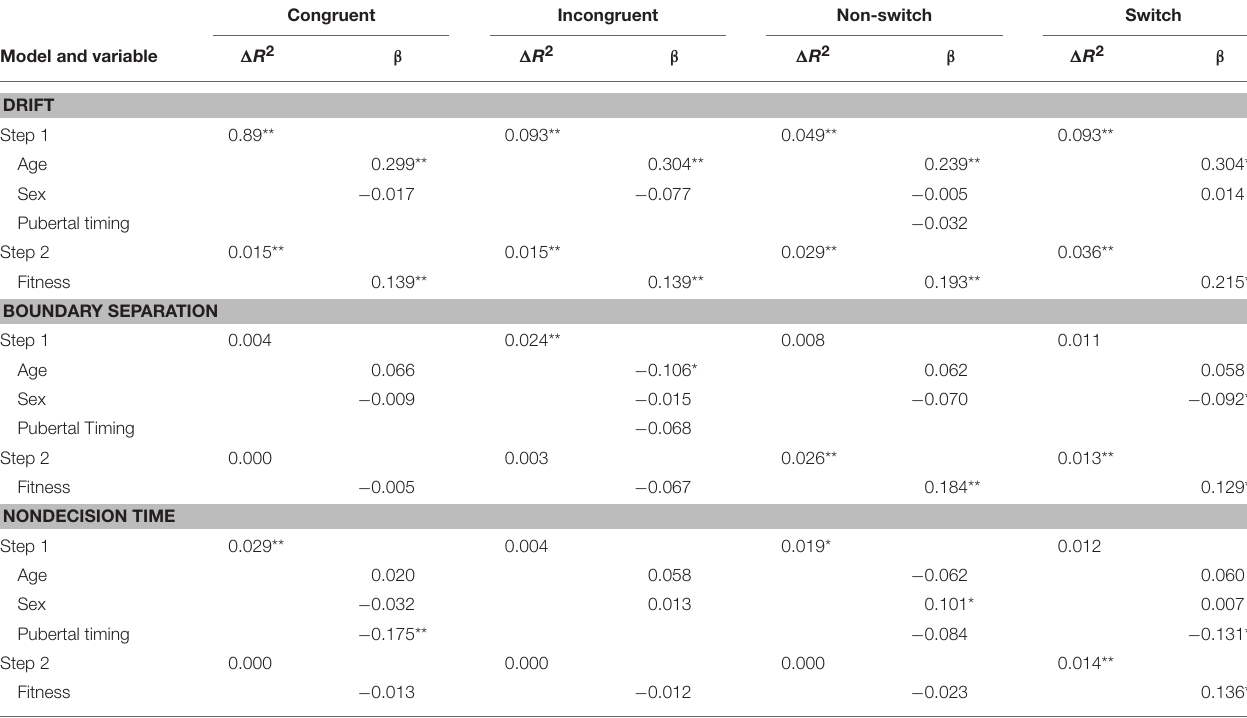
TABLE 5 | Summary of Hierarchical Regression Analyses for Flanker and Switch diffusion.